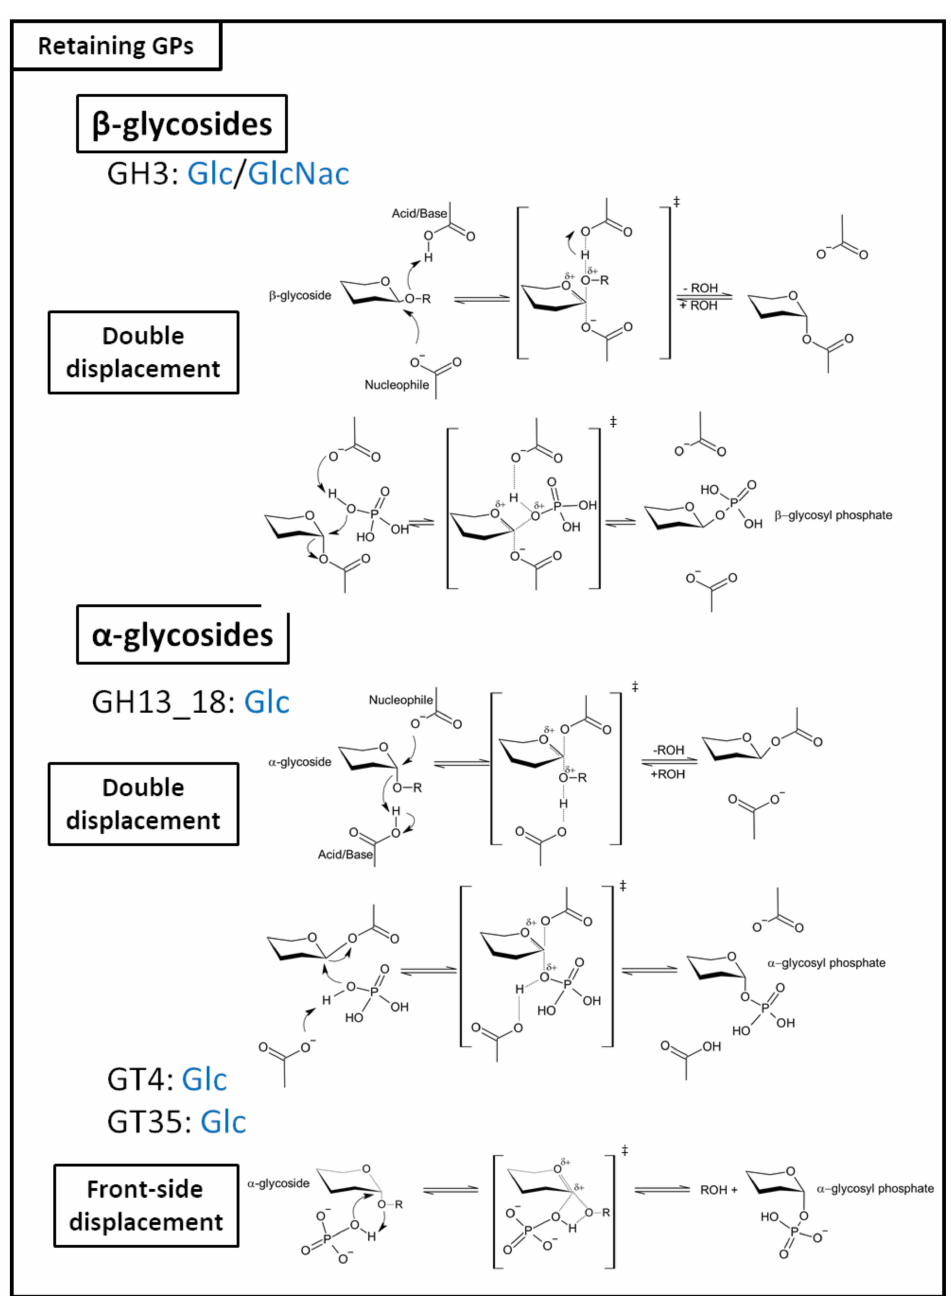
Figure 2. Retaining GPs catalytic mechanisms and family classification. The carbohydrates indicated for each family correspond to the glycosyl donors used by GPs of this